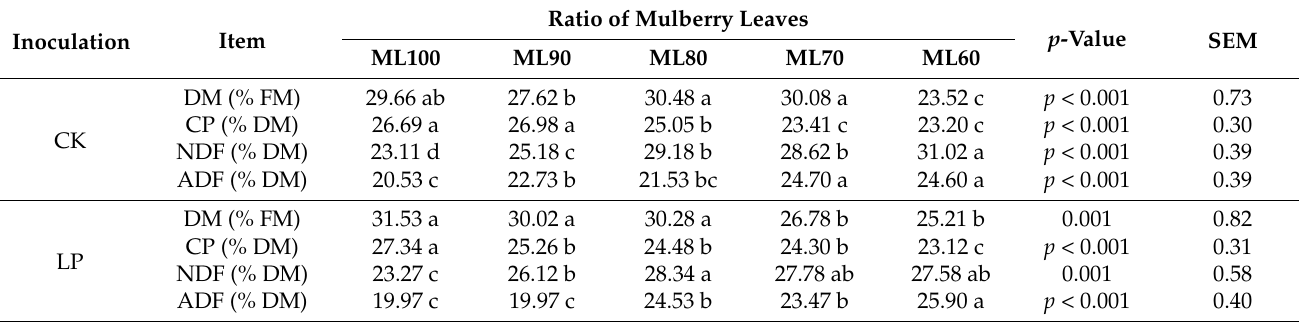
Table 2. Chemical compositions in mixed silage after 60 d